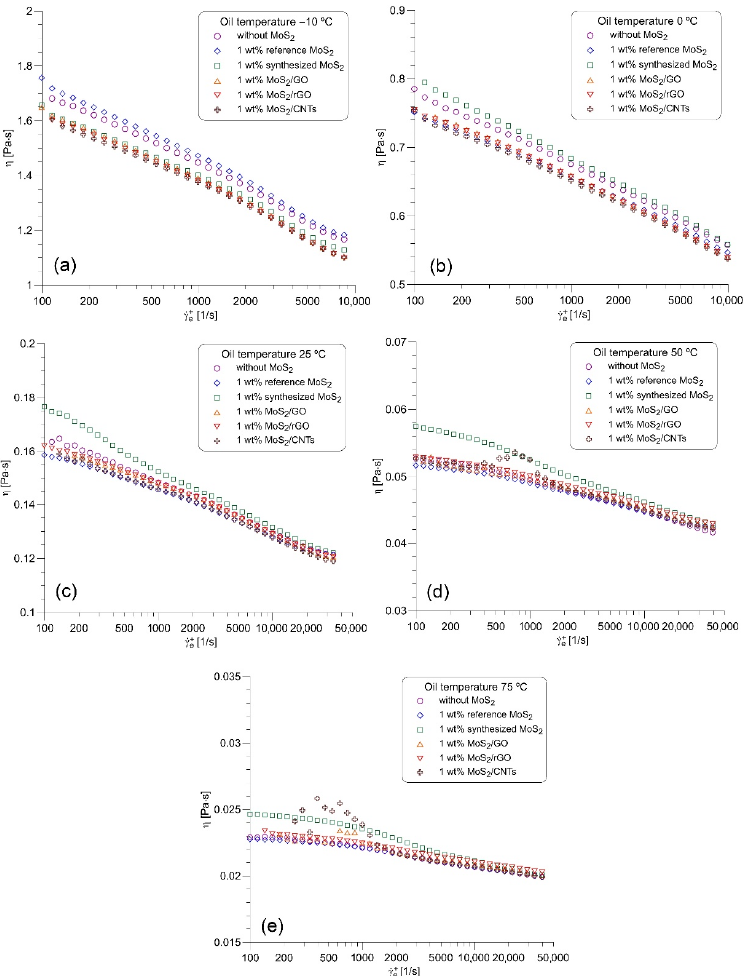
Figure 6. Refined viscosity curves of the pure base oil 10W40 and the base oil 10W40 with MoS 2 nanoparticles and nanohybrid particles: ( a ) − 10 °C, ( b ) 0 °C, ( c ) 25 °C, ( d ) 50 °C, ( e ) 75 °C.